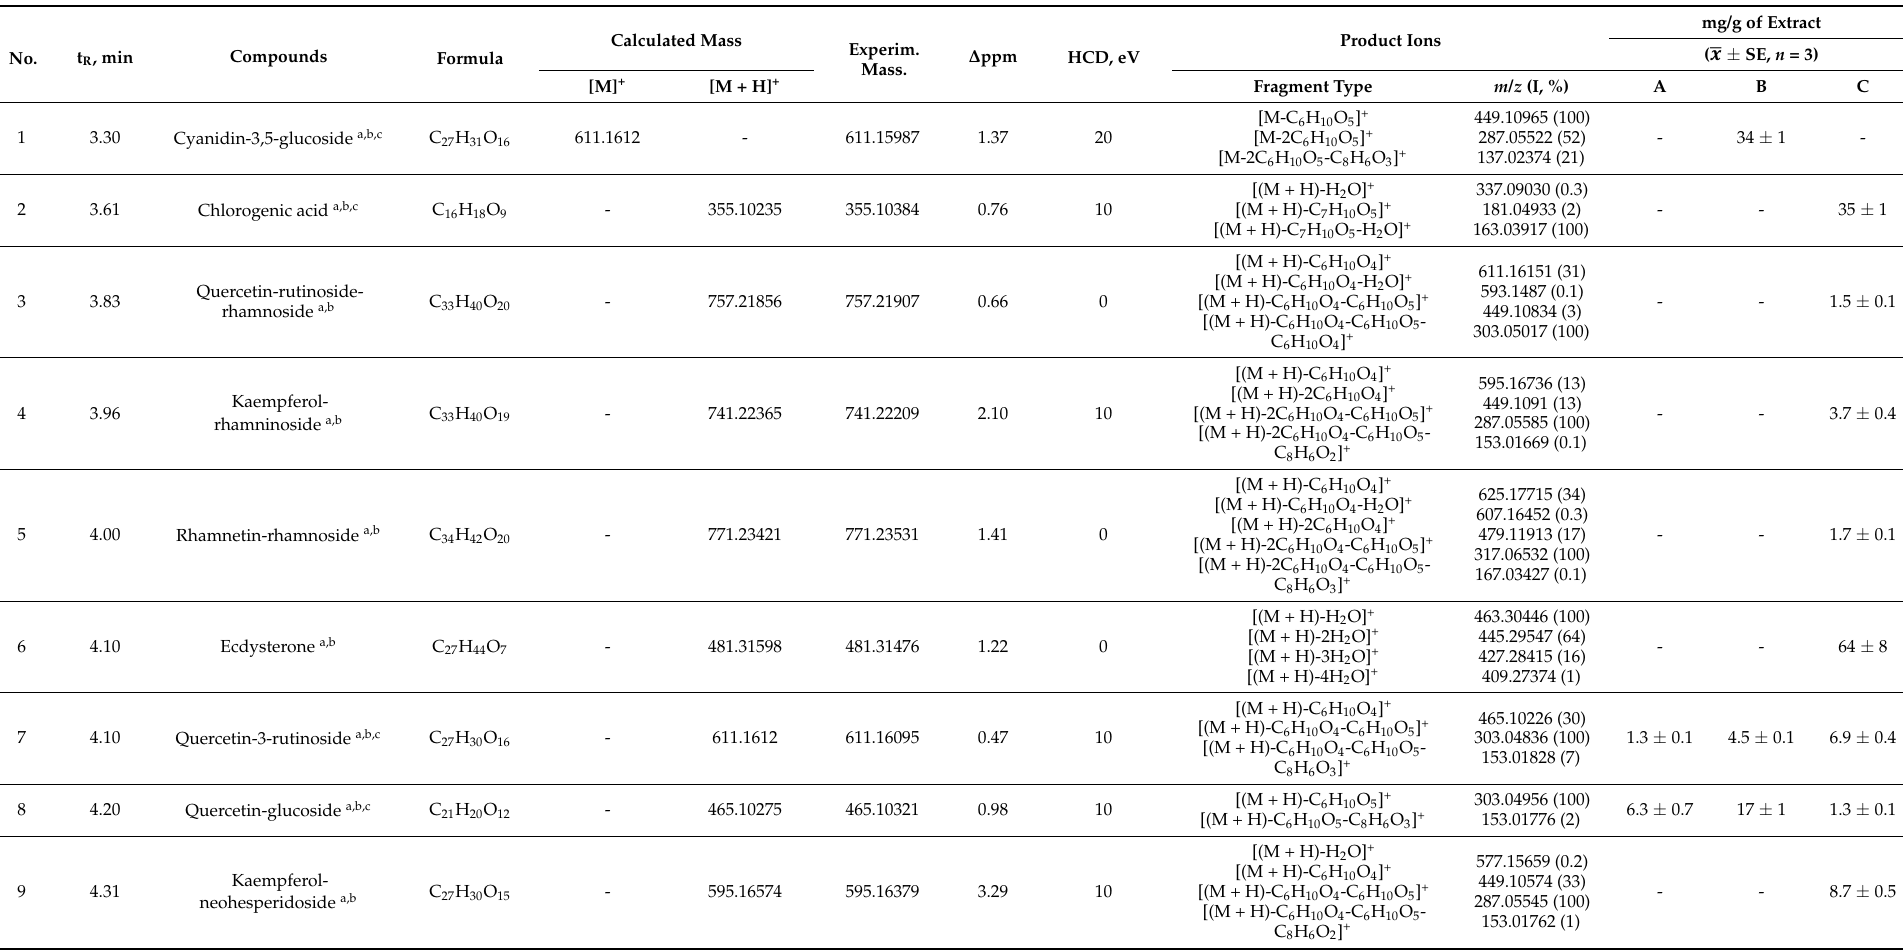
Table 3. Major constituents identified in flower extracts using UHPLC–ESI+–Orbitrap–MS. Extract constituents were dependent on their retention times (min) in chromatograms. The extracts were as follows: A— Rosa centifolia pink, commercial variety, B— Rosa centifolia fuchsia, commercial variety, and C— Posoqueria latifolia .